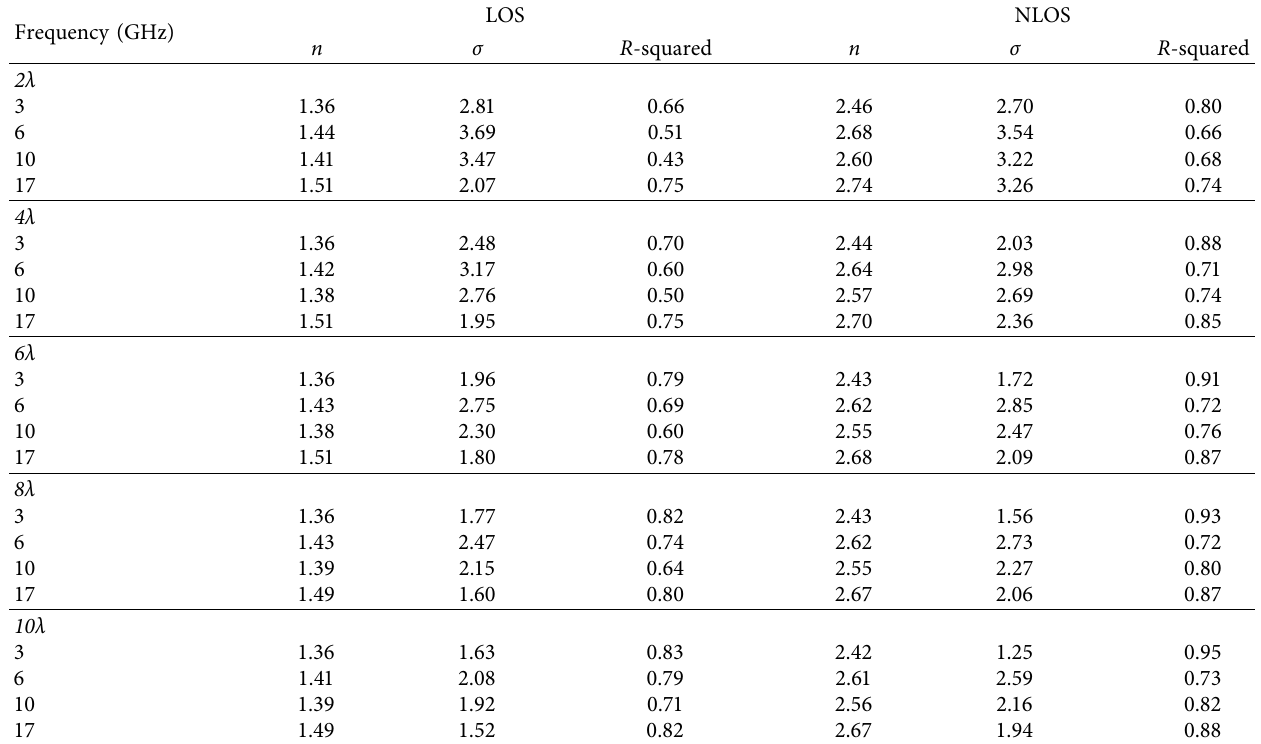
Table 2: Power loss coefcients, standard deviation, and R -squared of measured